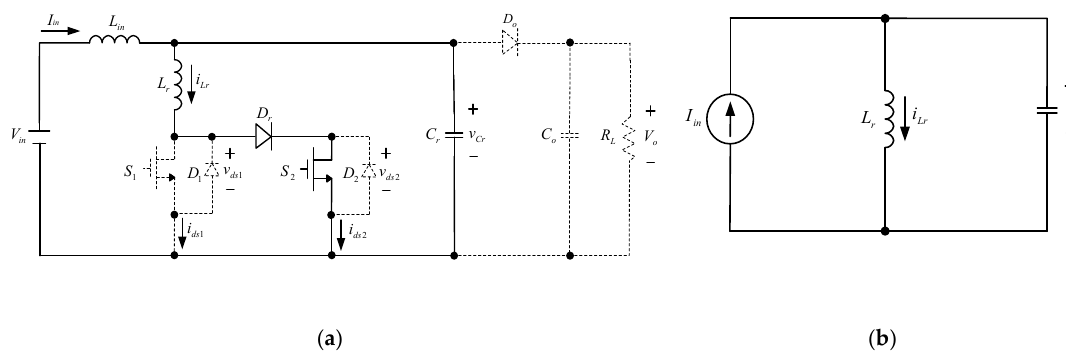
Figure 5. ( a ) Current flow in state 2; ( b ) Equivalent circuit of ( a ).